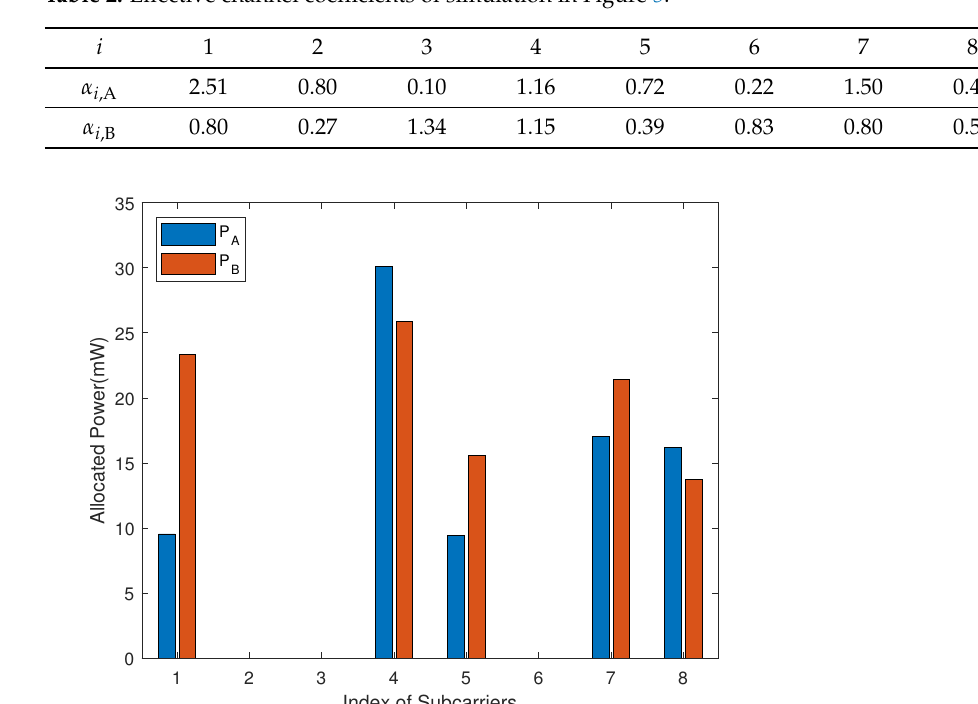
Table 2. Effective channel coefficients of simulation in Figure 5.